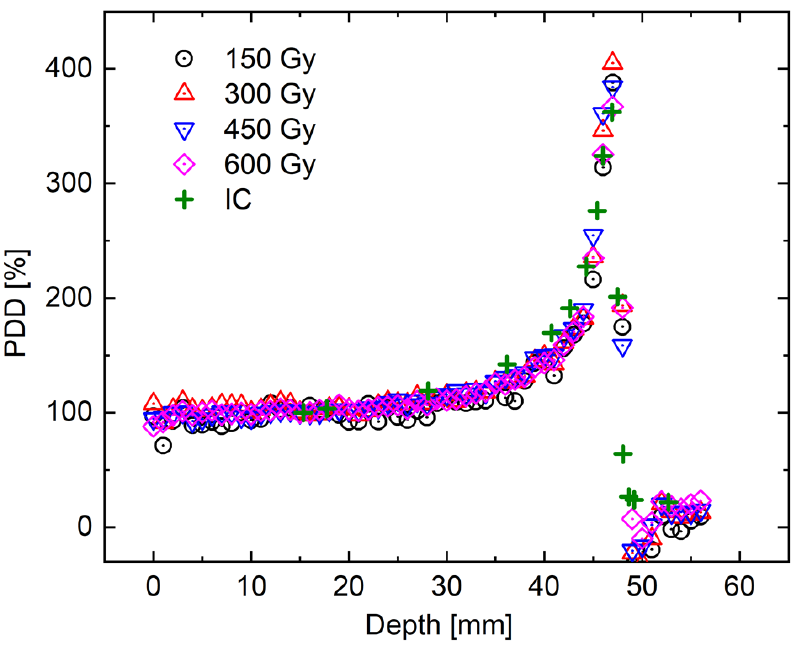
Figure 4. PDD curve under 290 MeV/u carbon ion beam irradiation. Comparison of the δ R 1 distributions with the physical dose distribution measured by the Markus IC.